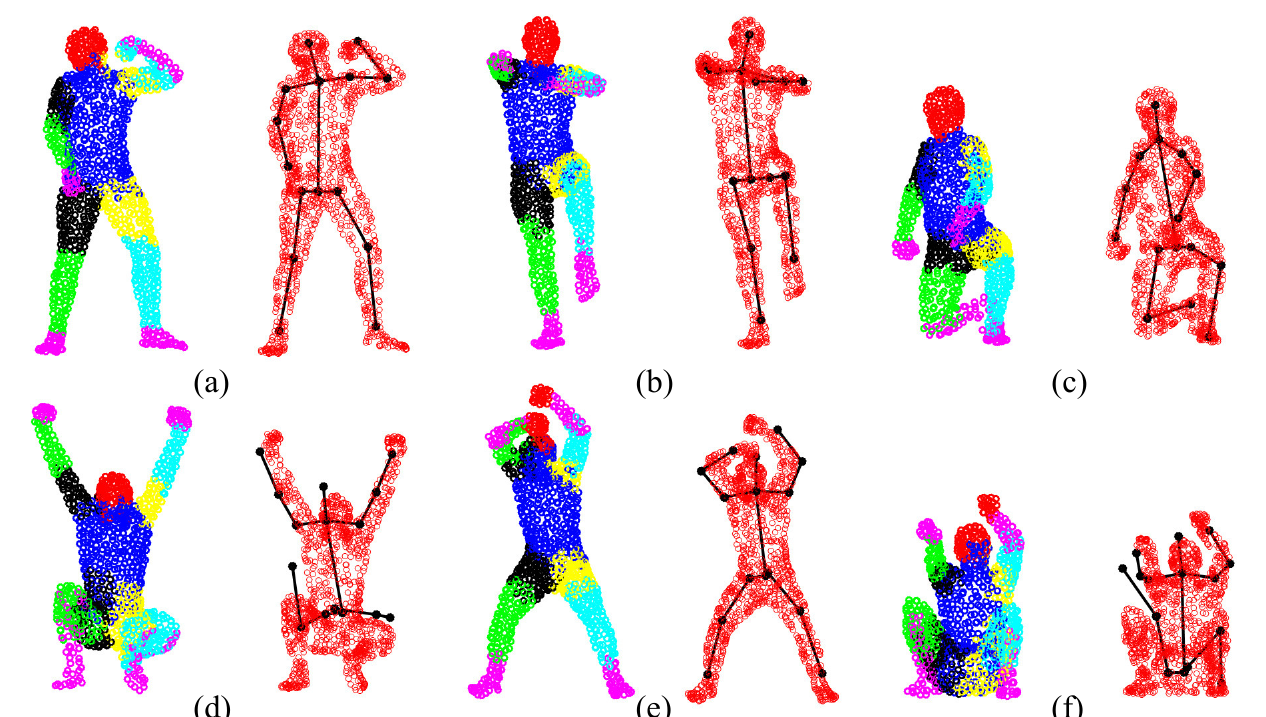
Figure 16. Some challenging cases in the SCAPE data (left: body segment labeling by GLTP; right: pose estimation by SAICP). The left arm/hand ( a , b ) and the right foot/leg ( c ) are mislabeled, which can be corrected during pose estimation. The two legs and feet ( d , f ) and the two hands and head ( e ) are labeled wrongly, which can be partially corrected by pose